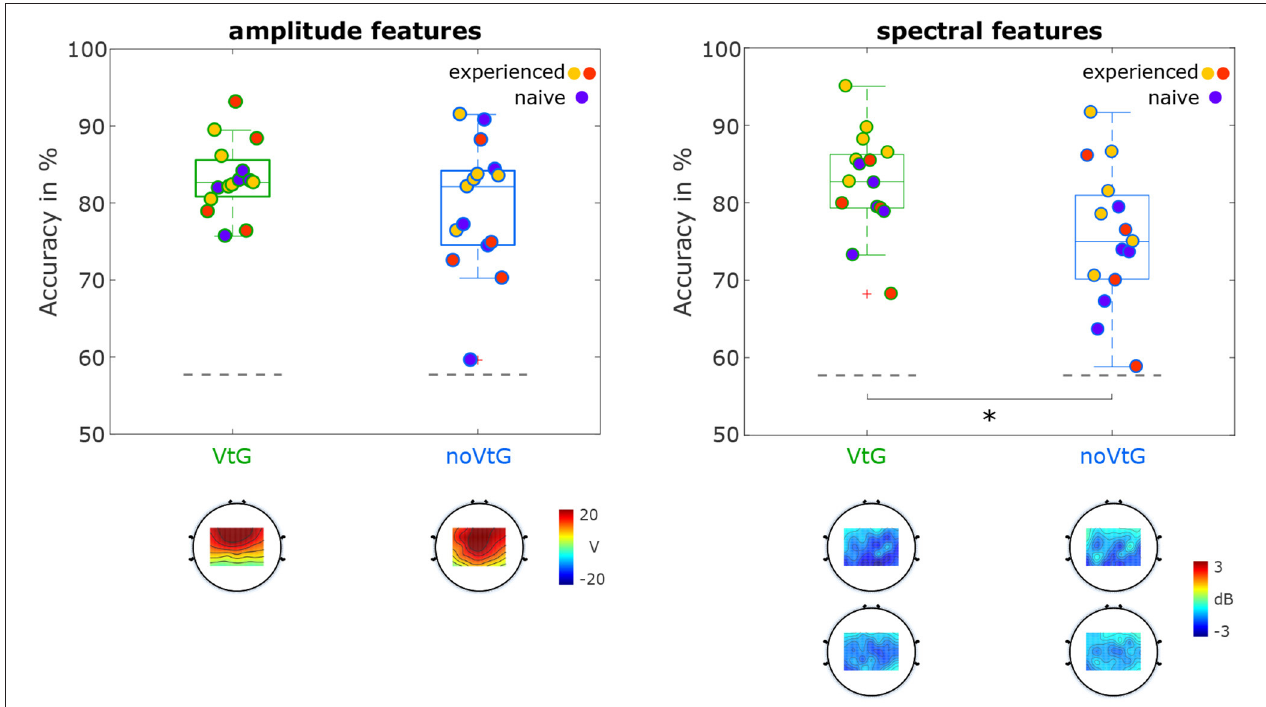
FIGURE 6 | Classification results for MI vs. baseline. The distributions of accuracies are presented as box plots, with the individual accuracies identified with the same color coding as in Figures 4 , 5 . Statistical difference is marked with an asterisk. The activation patterns of the amplitude features, and the power feature CSPs are shown below the box